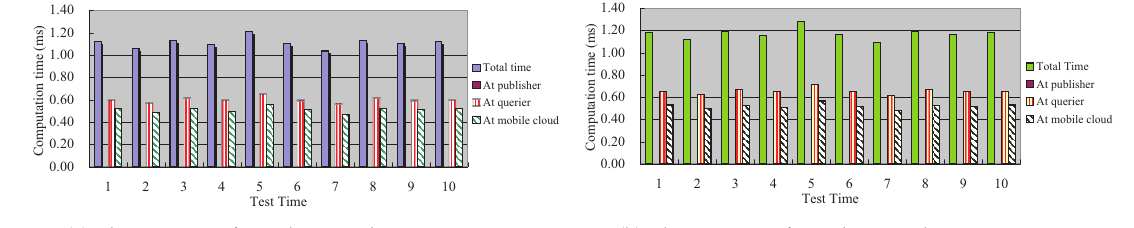
Figure 5. The time cost in our scheme.